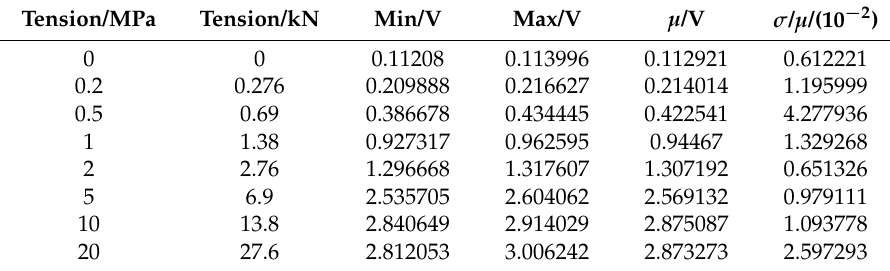
Figure 11. Mean of the magnitudes of the focused signals based on times reversal. Table 3. Five test’s